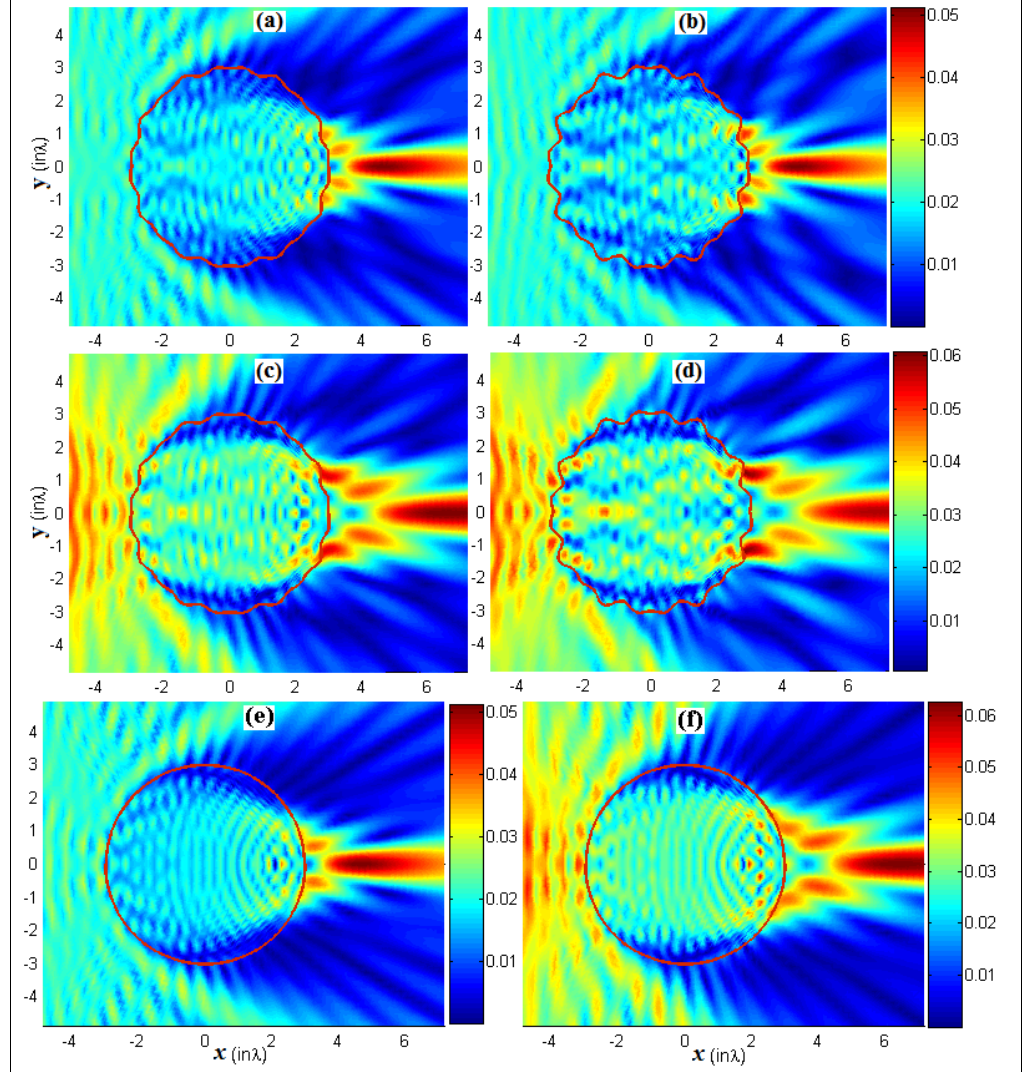
Figure 5. Total field inside and outside a dielectric corrugated cylinder whose ( R , n ) = (3 λ , 1.4) when illuminated by a point-source placed at different positions ( a ) d = 15 λ , β = 0.1, ( b ) d = 15 λ , β = 0.18, ( c ) d = 5 λ , β = 0.1, ( d ) d = 5 λ , β = 0.18, ( e ) d = 15 λ , β = 0, ( f ) d = 5 λ , β = 0. (The colormap denotes the total field